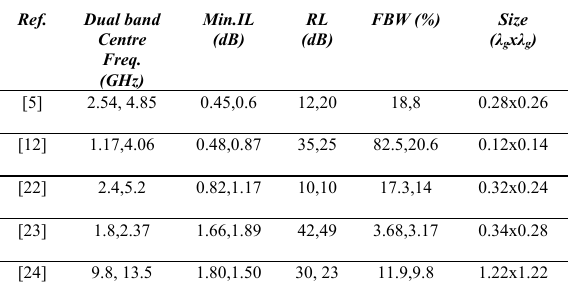
Table 1. Comparison of proposed filter with other contemporary works Ref. Dual band